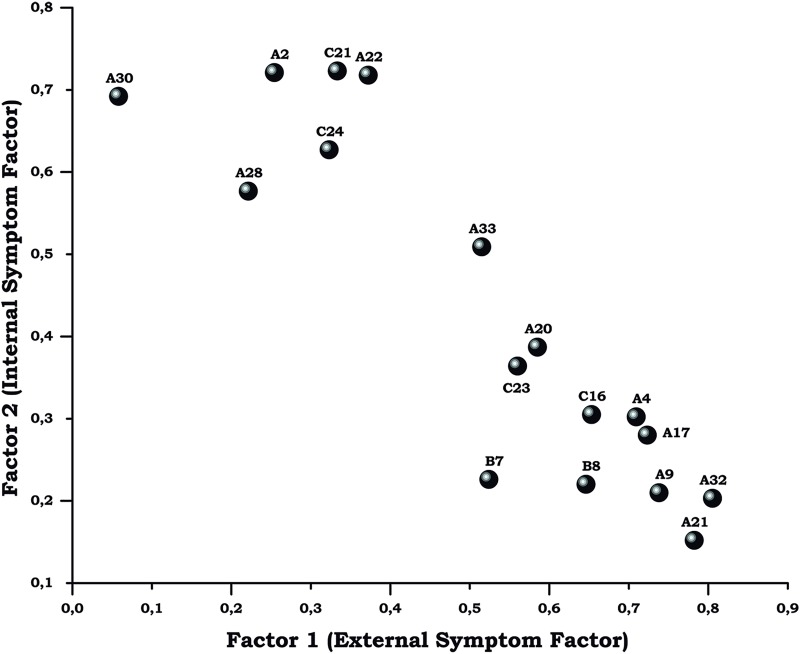
Factor loadings for CVSS17 principal components.Plot of the factor is loading for Factor 1 (external symptom factor, horizontal axis) against Factor 2 (internal symptom factor, vertical axis) for each of the CVSS17 items. Item descriptors are shown in Table 4.